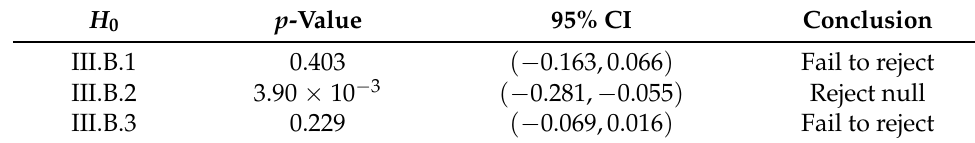
Table 4. Summary of two-tail t -test performed for each